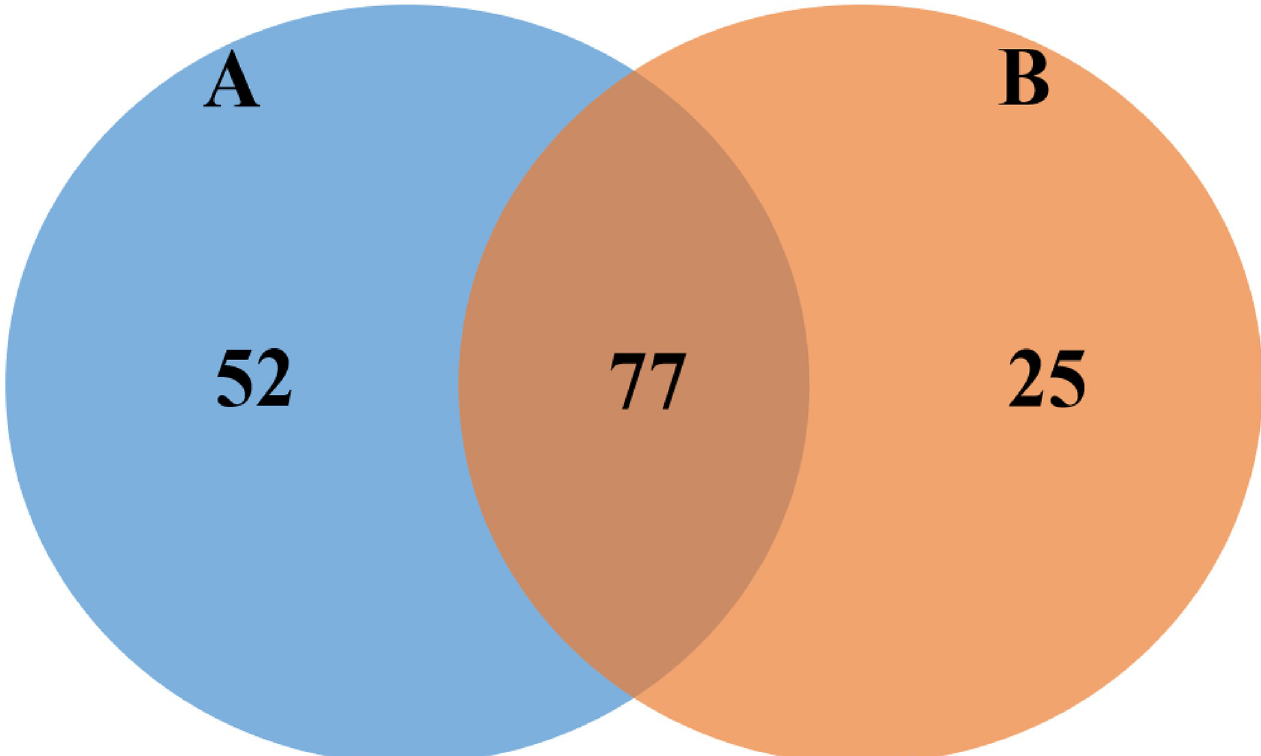
Fig 2. Comparison between the number of identified proteins in LPS-stimulated (A) and non-stimulated (B) hemocytes of T . gigas . A total number of 154 proteins were identified in both samples, 77 were commonly found in both samples. 52 proteins were uniquely found in the TgLPS, and 25 proteins were found in TgNS. TgNS, non-stimulated T . gigas hemocytes; TgLPS, lipopolysacharride-stimulated T . gigas hemocytes.